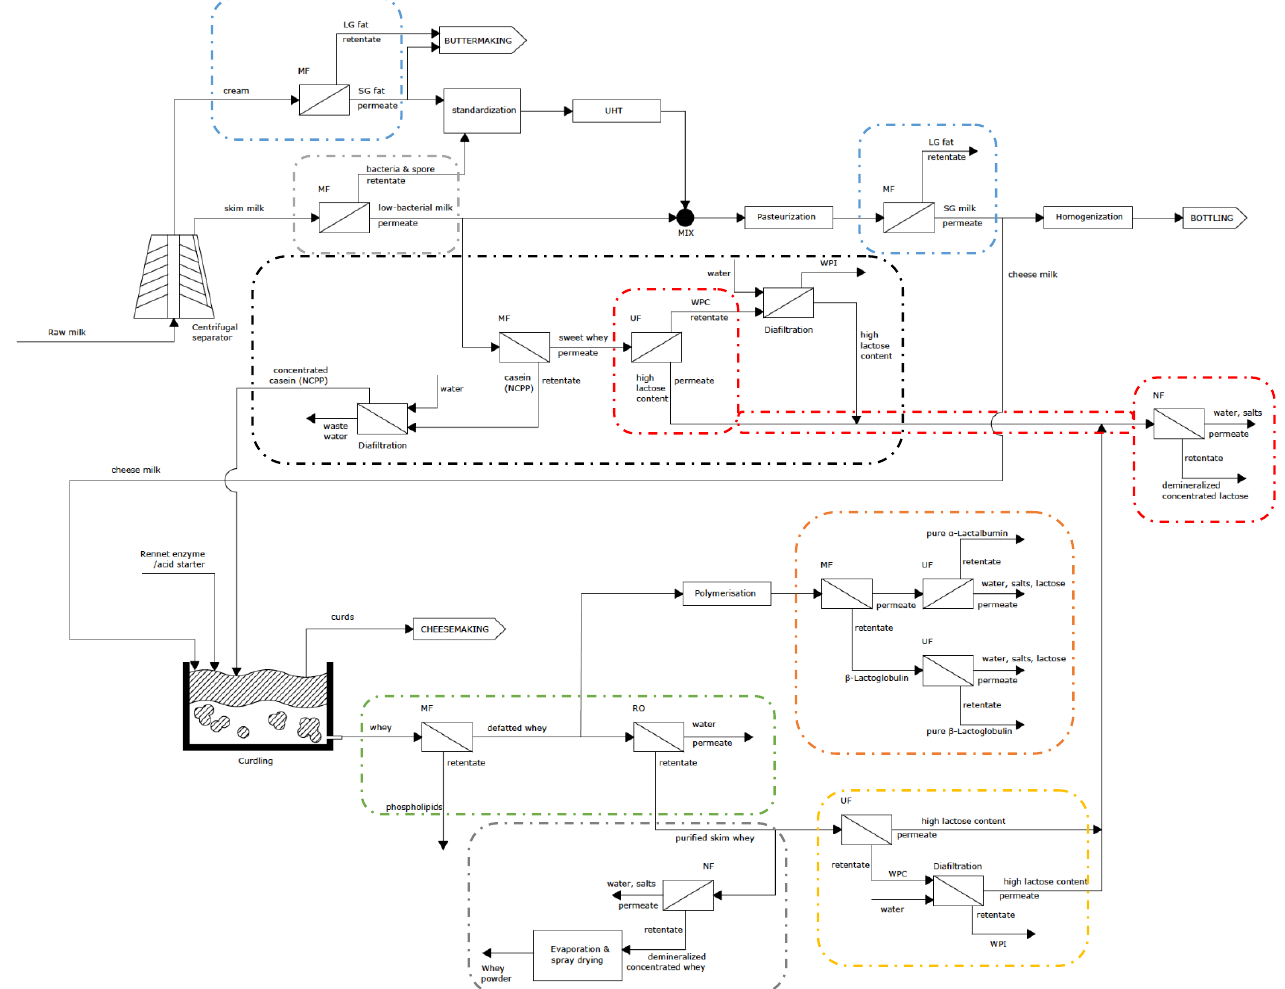
Figure 11. Membrane integration in dairy industries for milk and cheese